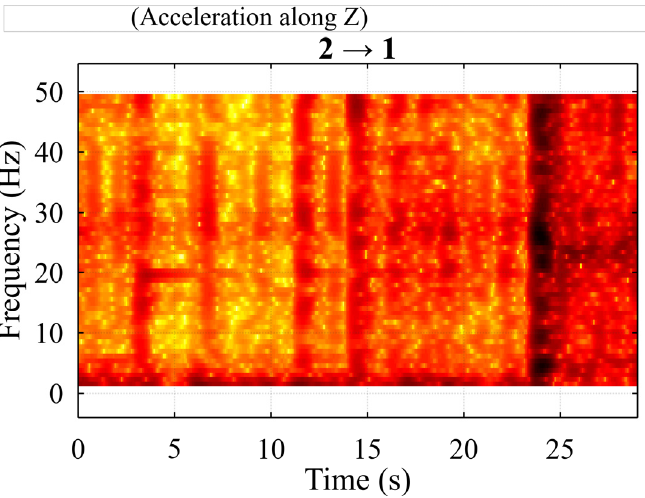
Figure 13. Acceleration spectrogram along the Z-axis.